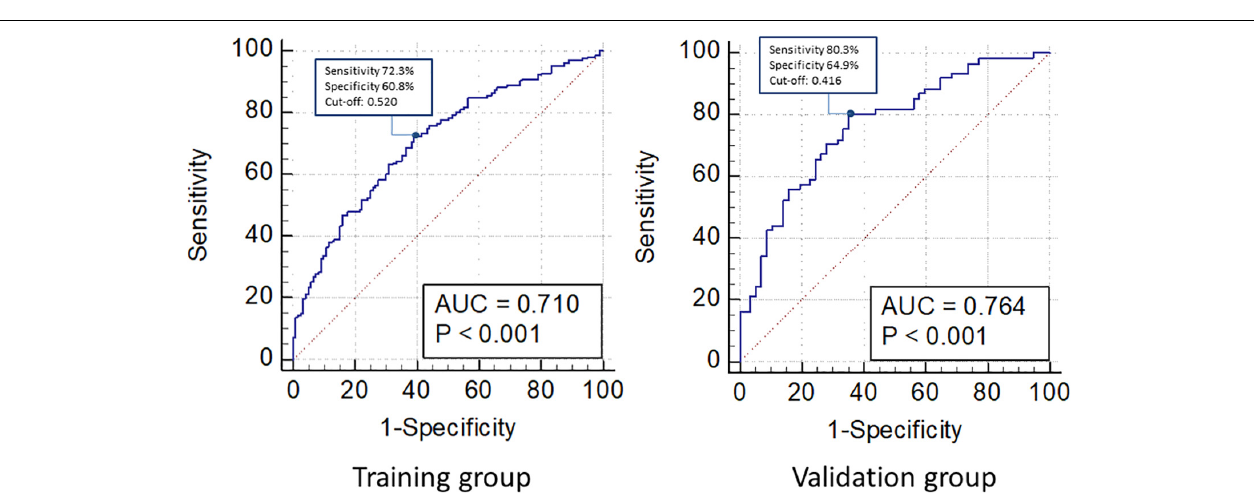
FIGURE 4 | Receiver operating characteristic (ROC) curve for individualized prediction model to predict 3-month poor functional outcome in training and validation group. In the training group, area under the curve (AUC) was 0.710. Cutoff point was marked on the figure with sensitivity 72.3%, specificity 60.8%, and cutoff value was 0.520. In the validation group, AUC was 0.764. Cutoff point was marked on the figure with sensitivity 80.3% and specificity 64.9% and cut off value was